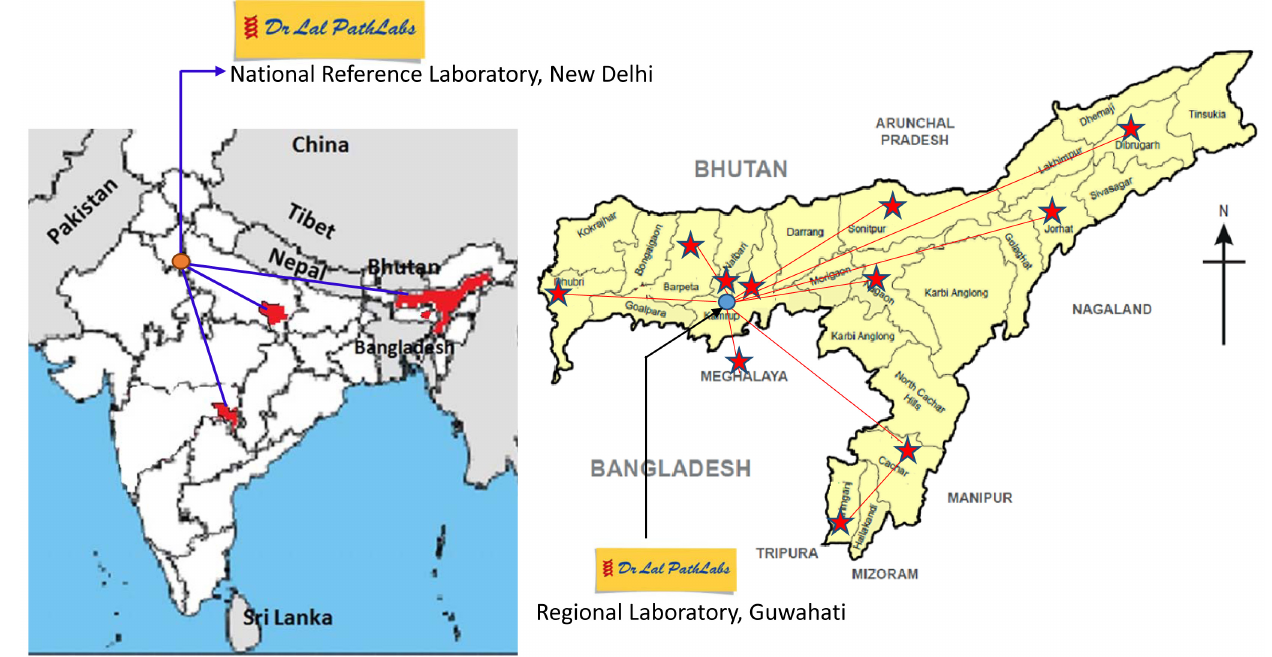
Figure 3. Laboratory network for the MaatHRI